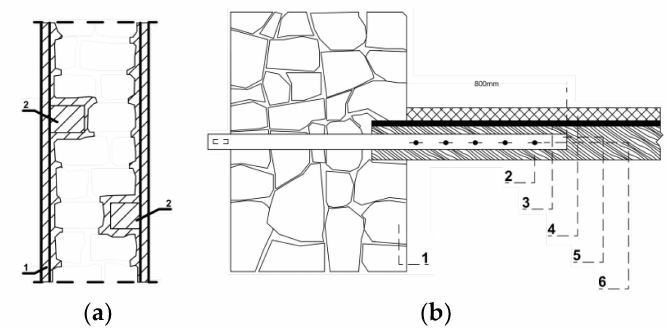
Figure 17. Technical details: ( a ) 1—Reinforcement with the reinforced cladding; 2—connection with the wall by concrete “niches”; ( b ) connection of a wooden mezzanine structure to a stone wall: 1—existing stone wall; 2—existing wooden beam; 3—wooden mat; 4—new cement screed; 5—steel strip; 6—elsers (Drawings: Lejla